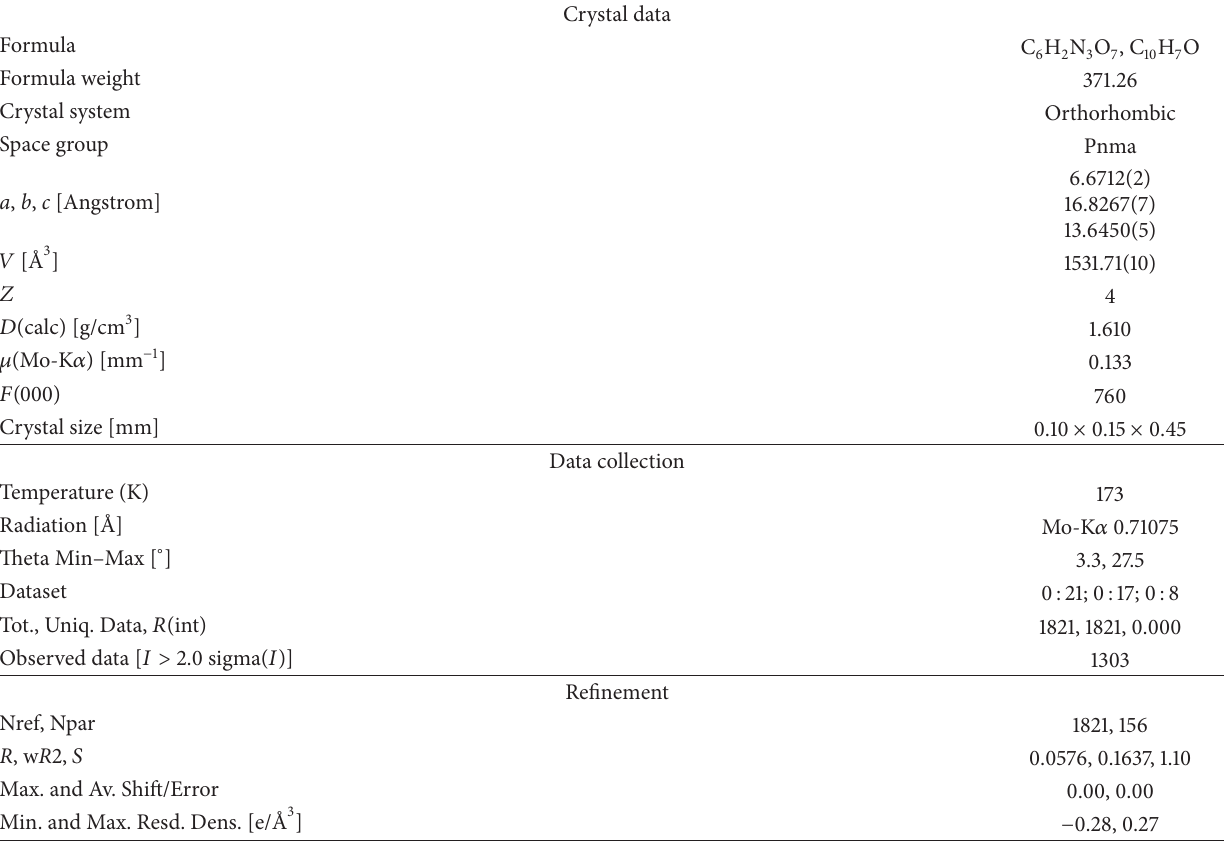
Table 1: Crystal data and structure refinement for the compound.